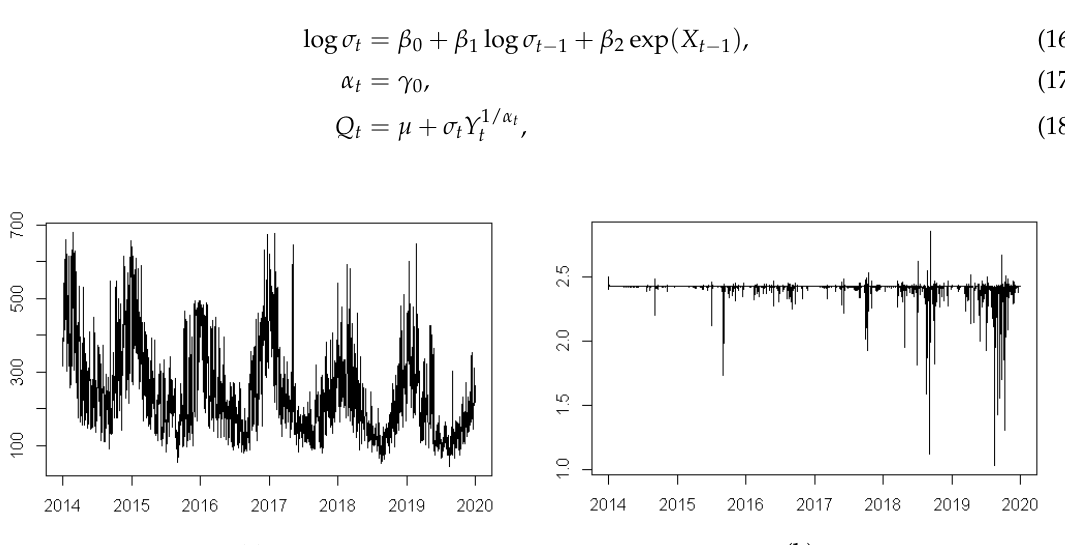
Figure 10. ( a ) The sequence of fitted σ t generated from the model, including weather factors; ( b ) the graph of fitted α t